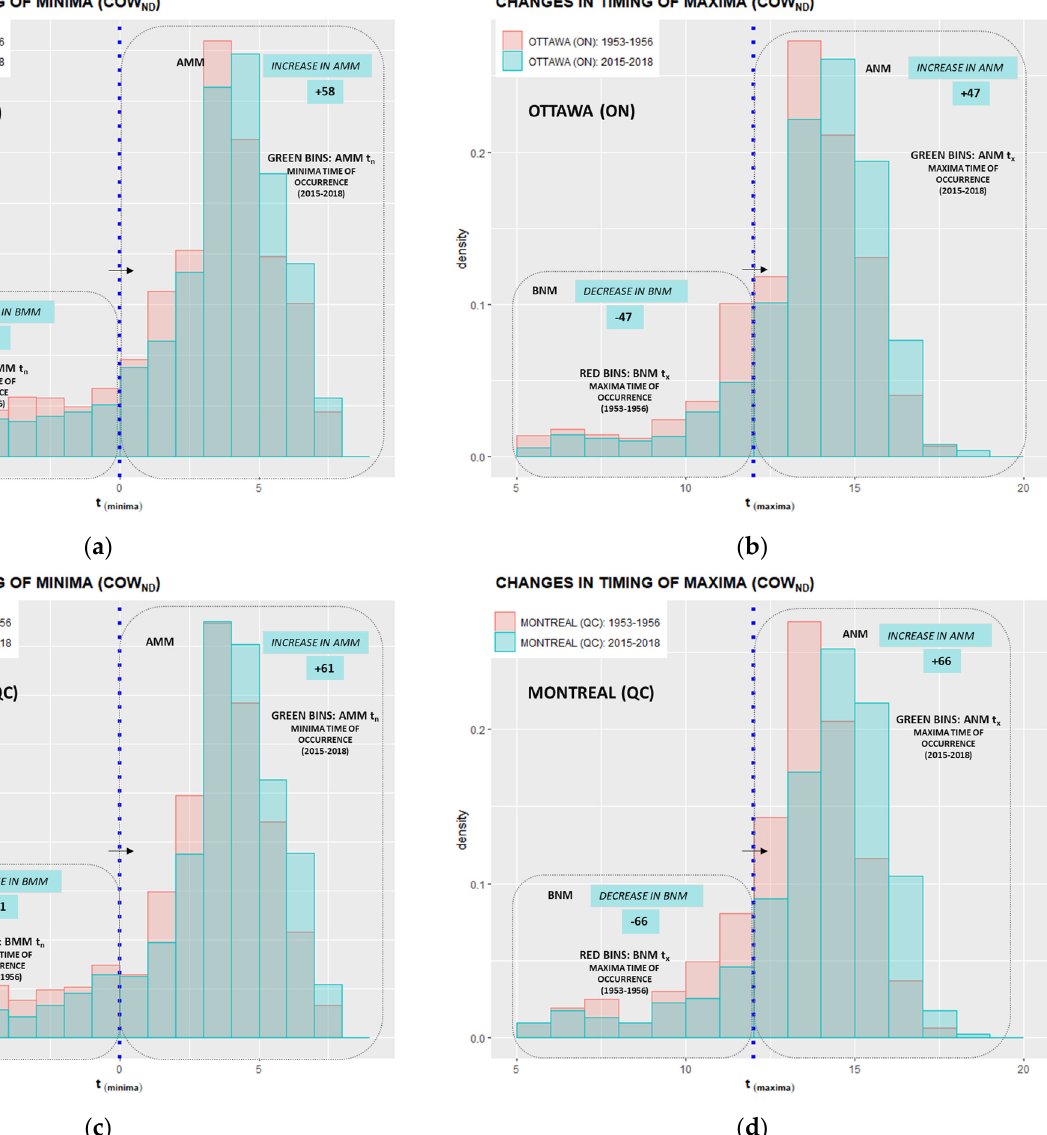
Figure 9. Time evolution of diurnal extrema timing histograms for the Great Lakes/St. Lawrence Lowlands climate region, at Ottawa ( a , b ), and Montreal ( c , d ) stations. Migration of Before Midnight Minima (BMMt n ) to After Midnight Minima (AMMt n ) and Migration of Before Noon Maxima (BNMt x ) to After Noon Maxima (ANMt x ) between four-year averages at the beginning (1953–1956) and ending (2015–2018) of data ranges. The blue dotted line represents midnight delineation ( left ) and noon delineation ( right ).